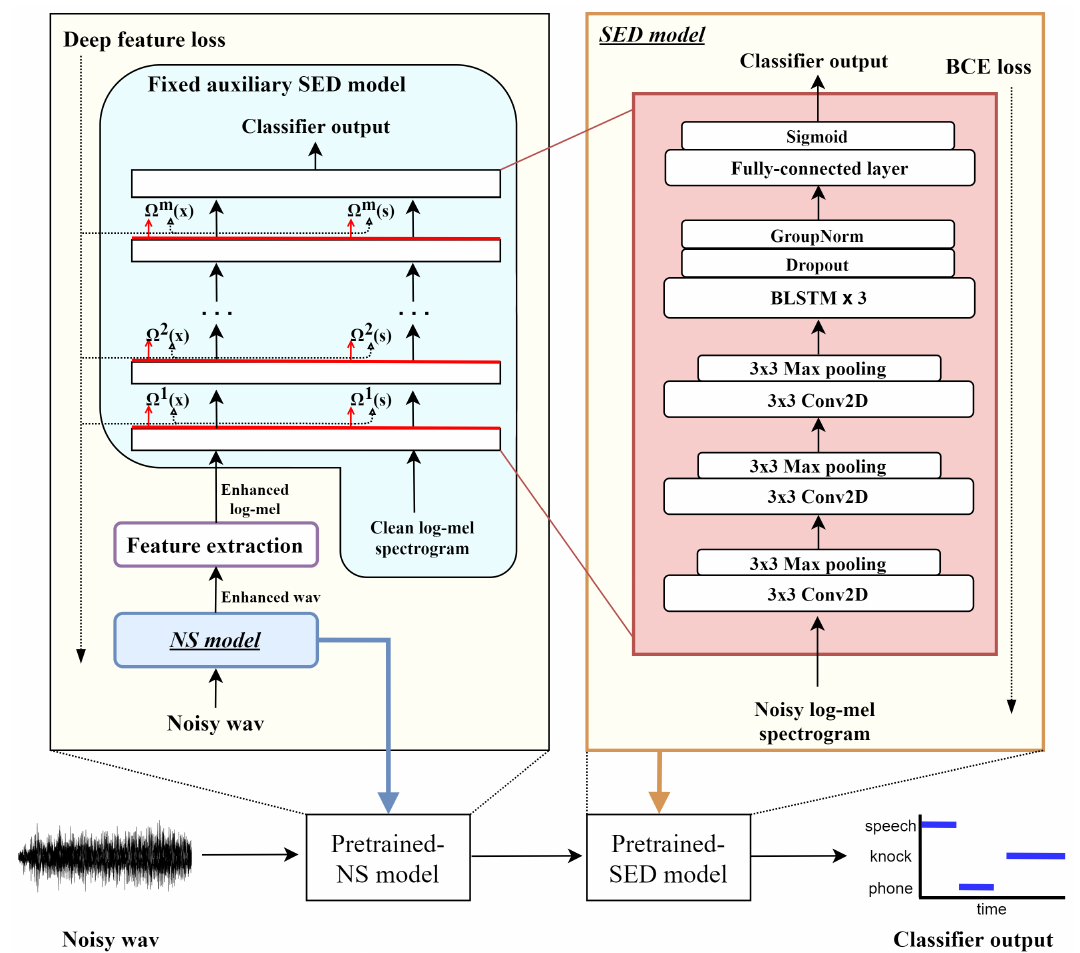
Figure 1. Overall structure showing pretraining process before joint training, where s and x denote the clean and enhanced features, respectively. Additionally, m is the number of layers, Ω m ( · ) is the activation feature output of the m th layer, and classifier output is the event presence probability